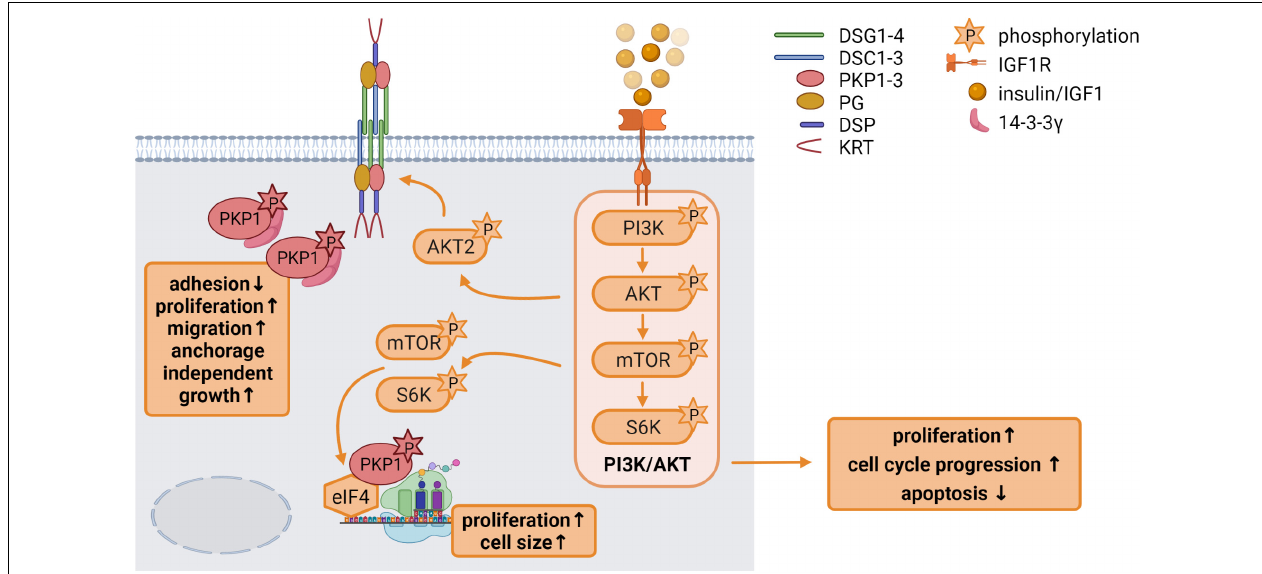
FIGURE 3 | Insulin like growth factor 1 (IGF1) signaling is an important regulator of epidermal homeostasis (created with biorender.com) . Binding of IGF1 activates the IGF1R and the downstream PI3K/AKT signaling cascade via the phosphorylation of its components PI3K, AKT, mTOR, and S6K, resulting in increased proliferation and cell cycle progression as well as decreased apoptosis. Activated AKT2 phosphorylates PKP1, which translocates from the cell membrane to the cytoplasm. Phosphorylated cytoplasmic PKP1 is stabilized and protected from degradation via 14-3-3 γ binding, resulting in impaired adhesion but increased proliferation, migration and anchorage independent growth. mTOR and S6K regulate binding of translation initiation factors of the eIF4 complex to mRNAs, thereby promoting protein biosynthesis. Phosphorylated PKP1 interacts with this translation initiation complex and stimulates eIF4A activity thereby facilitating unwinding of secondary structures in the 5 (cid:48) -UTR. The increase in protein biosynthesis correlates with increased proliferation and cell